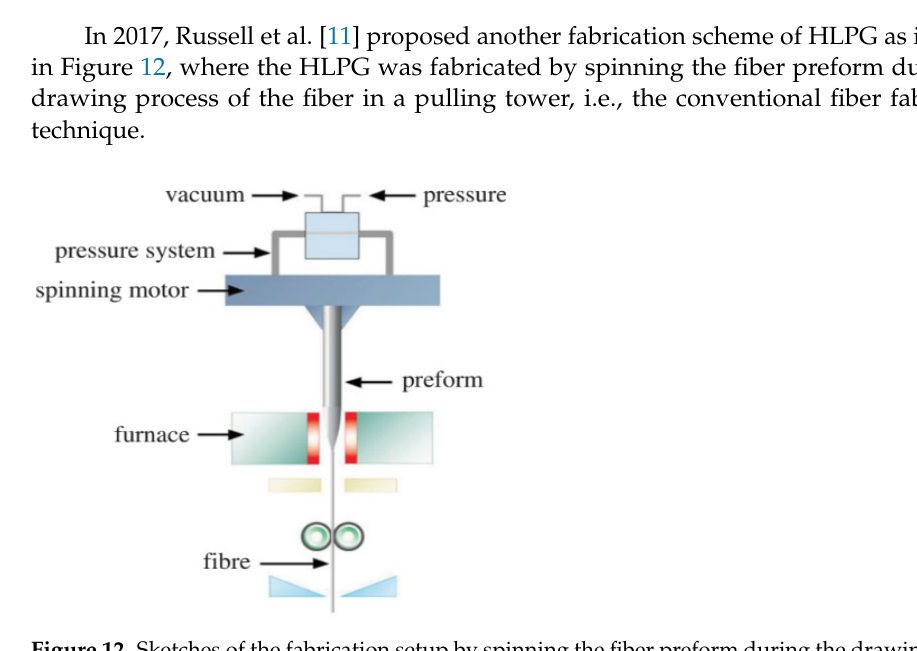
Figure 11. Schematic diagram of the online HLPG fabrication setup. Adapted with permission from Ref. [12] © The Optical Society.